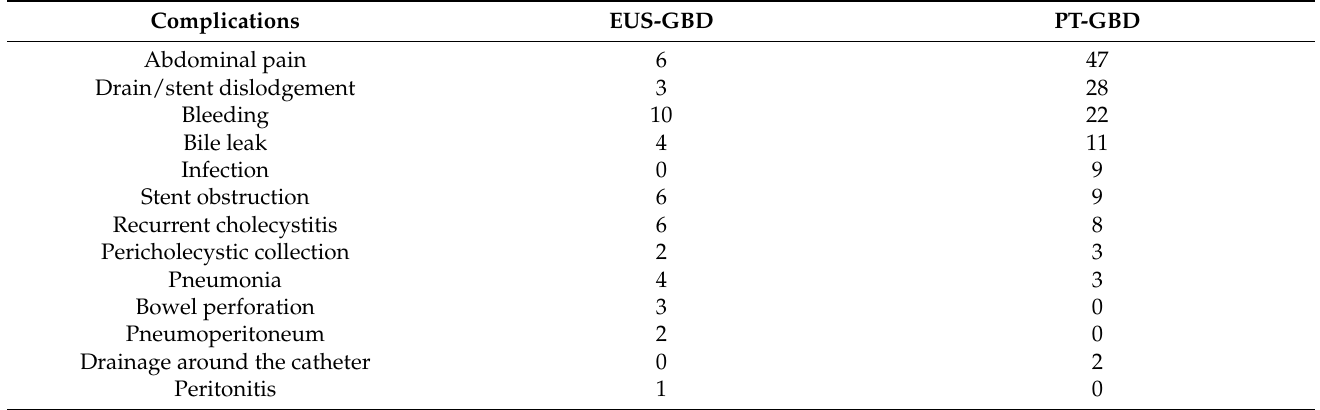
Figure 2. Forest plot for technical and clinical success. Table 2. Common complications associated with gallbladder